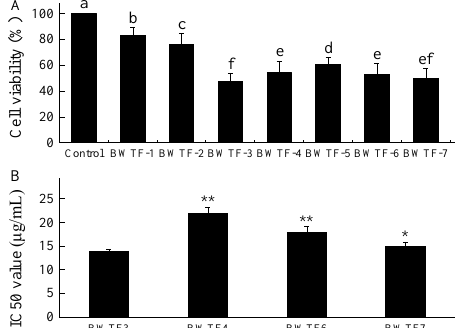
Figure 3. Anti-tumor activity of buckwheat flavonoids. ( A ) Total flavonoids of tartary buckwheat (BWTFs) were tested for inhibition activity on MGC 80-3 cells. BWTFs exhibited statistically inhibition activity. One-way ANOVA with LSD was applied for multicomparison. Bars with different letters indicate a statistical difference ( p < 0.05), respectively. Bars bearing same letter mean not significant ( p > 0.05). The control was treated with medium only. ( B ) The 50% inhibitory concentrations (IC50s) of BWTFs. One-way ANOVA with LSD was used to determine significant differences. * or ** indicates significant levels of differences at p < 0.05 or p < 0.01 with respect to BWTF3, respectively. Values were expressed as the mean ± SD from experiments in triplicate.